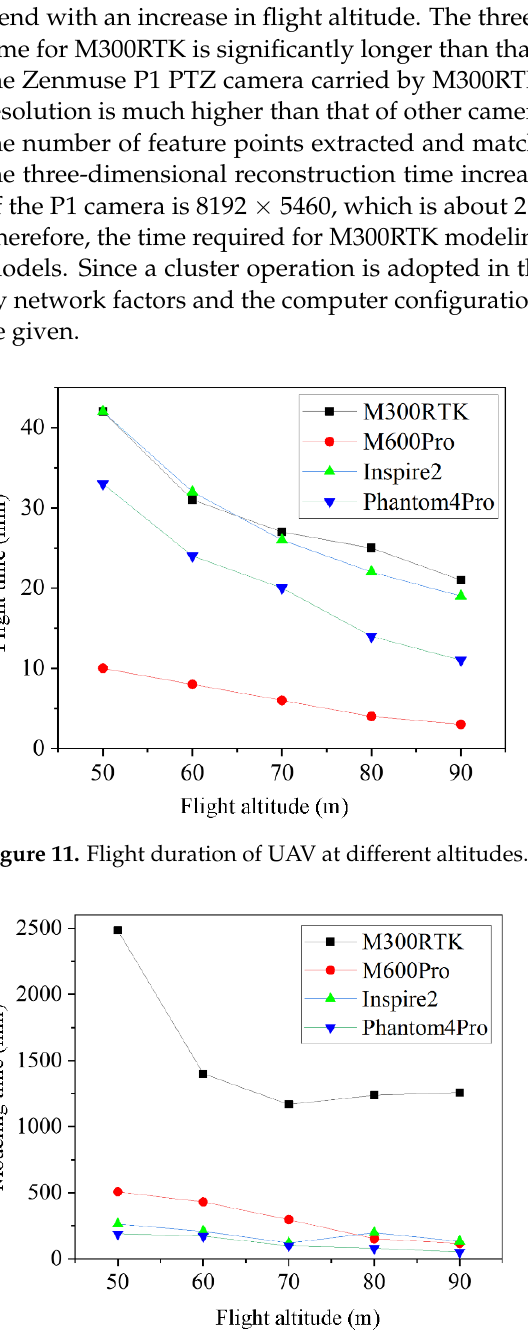
Figure 12. Three-dimensional reconstruction time for each 3D reconstruction model.